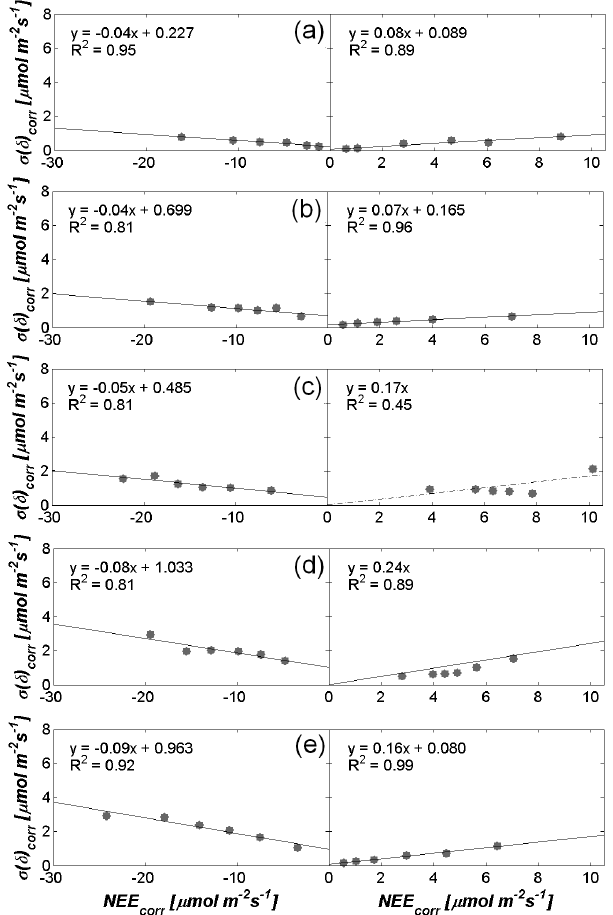
Figure 5. NEE uncertainty σ(δ) corr determined with the extended two-tower approach as function of sfd-corrected NEE corr magni- tude (Eq. 2) for the EC tower distances 8m (a) , 95m (b) , 173m (c) , 20.5km (d) and 34km (e) ; dashed line: linear correlation not significant ( p > 0.1).